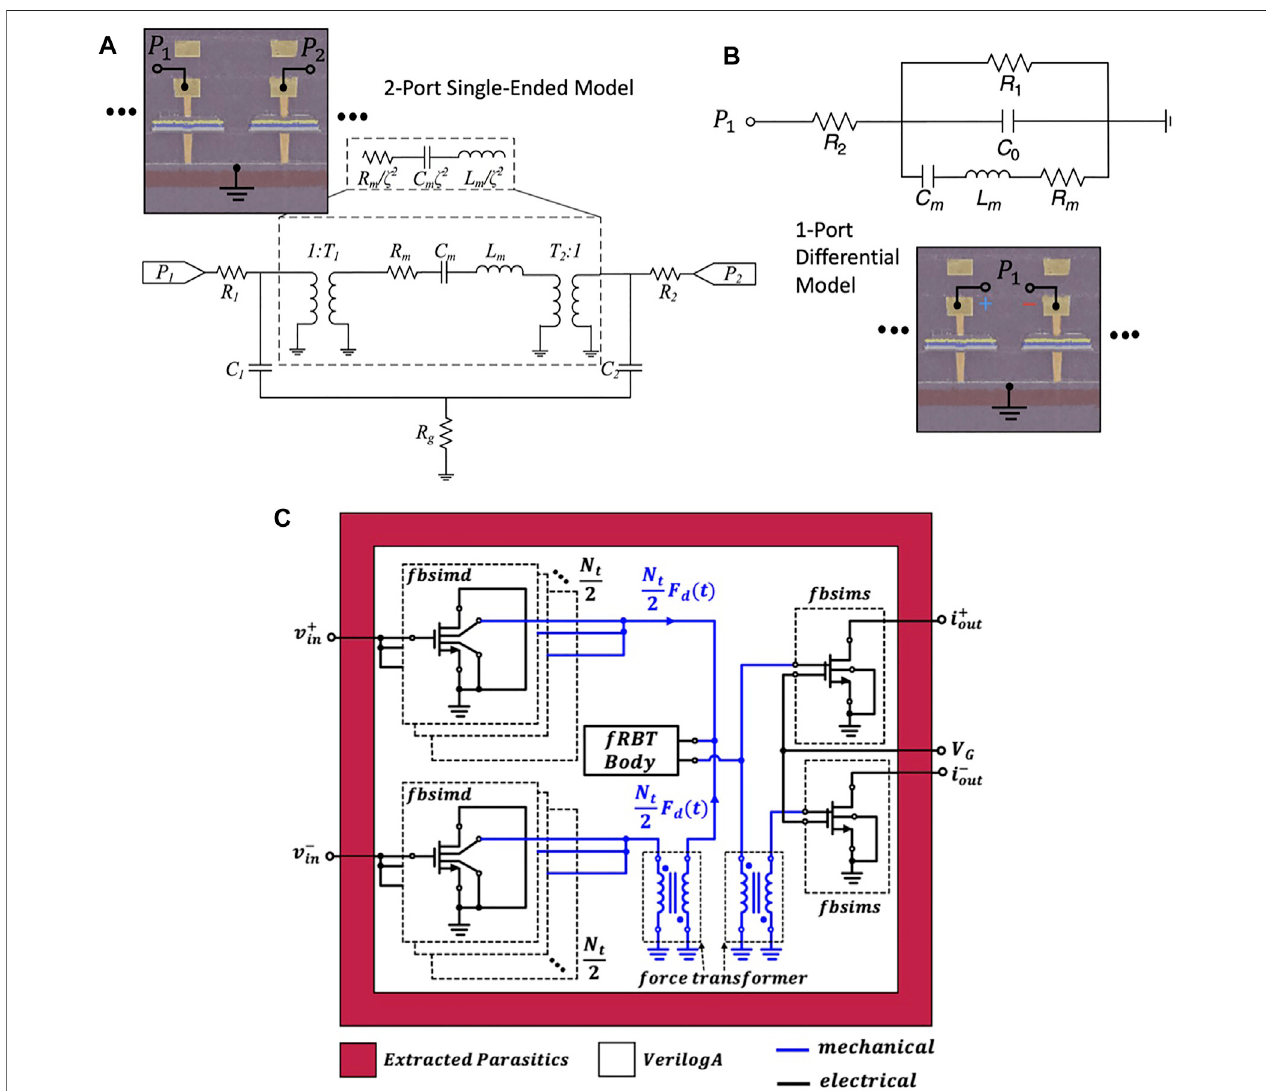
FIGURE 9 | (A) Two-port MBVD model for the FeCAP resonator consisting of the motional branch components ( R m , L m and C m ), transduction capacitances ( C 1 and C 2 ), parasitic resistances ( R 1 and R 2 ) and electromechanical transduction factors ( T 1 and T 2 ). (B) One-port differential model for the FeCAP resonator. (C) Compact model schematic for the GF14LPP fRBT device comprising of the modi fi ed BSIM-CMG transistor modes (fbsims and fbsimd), the extracted motional parameters (fRBT Body) and additional force transformers to ensure correct differential operation of the